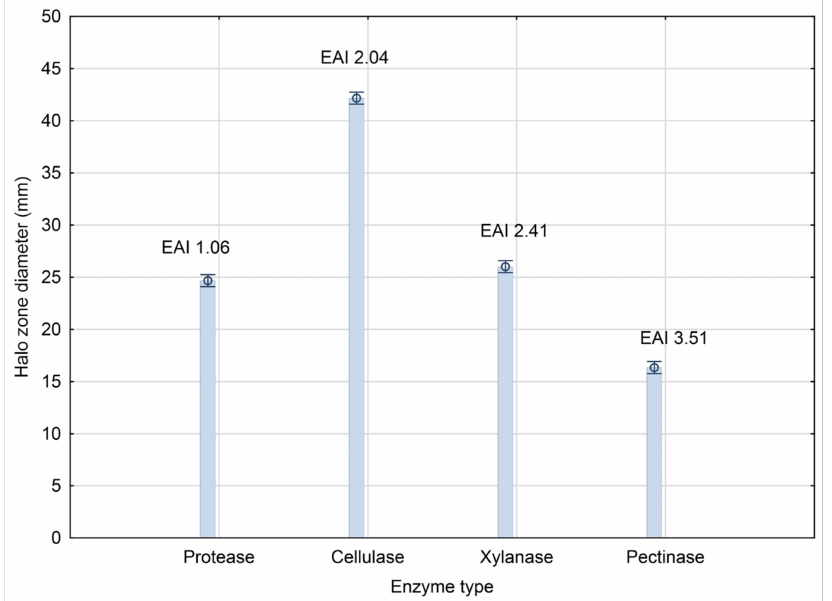
Figure 1. Screening of enzymatic activity of the producing strain Bacillus sp. BioSol021. EAI — enzymatic activity index. Table 4. Growth parameters of Bacillus sp. BioSol021 under different cultivation conditions estimated using Gompertz, logistic, and exponential plateau kinetic